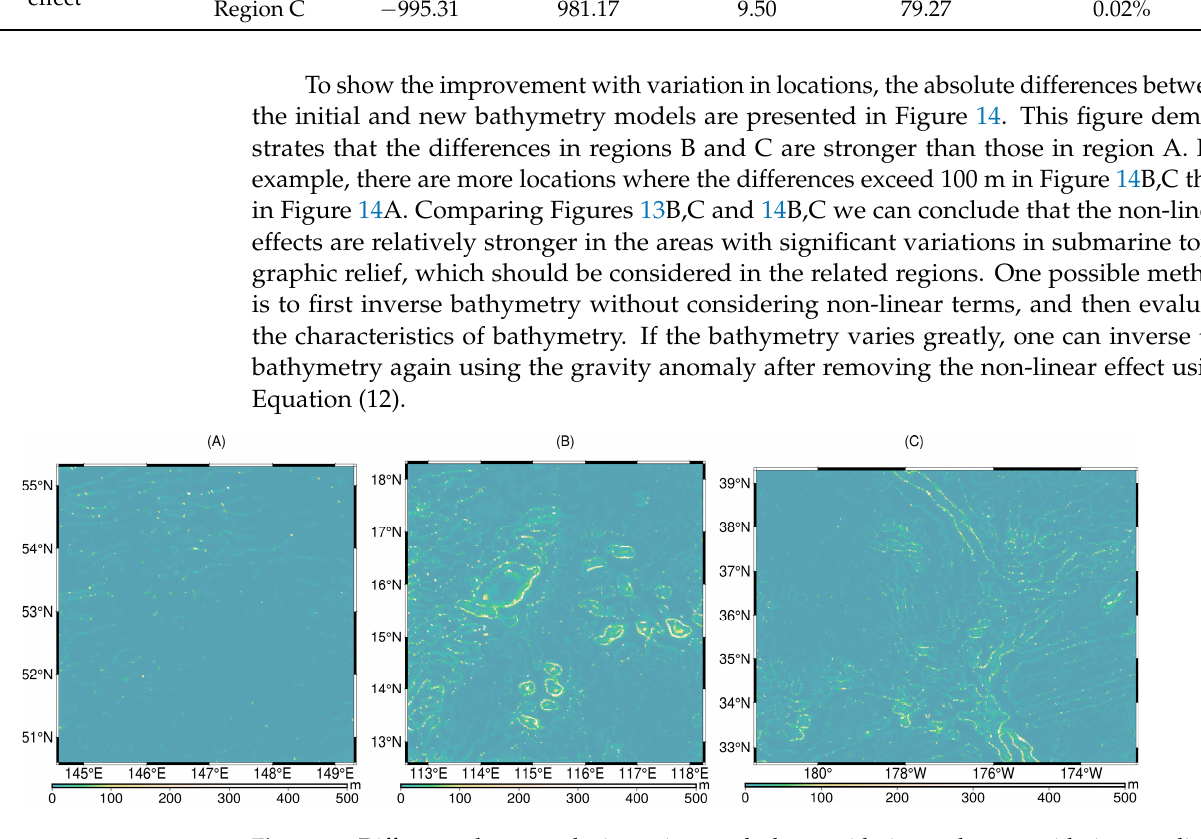
Figure 14. Differences between the inversion results by considering and not considering non-linear effect: ( A ) Region A; ( B ) Region B; and ( C ) Region C.